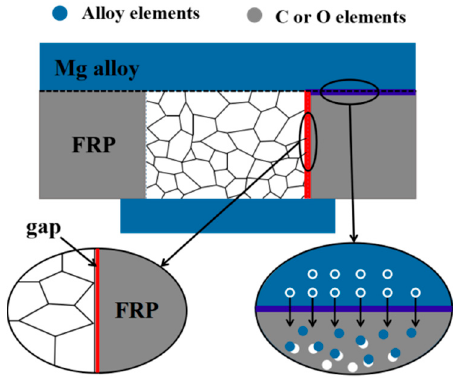
Figure 11. XPS of the interface in Figure 9d: ( a ) Mg, ( b ) O, ( c ) C, ( d ) Al, and ( e ) Si.